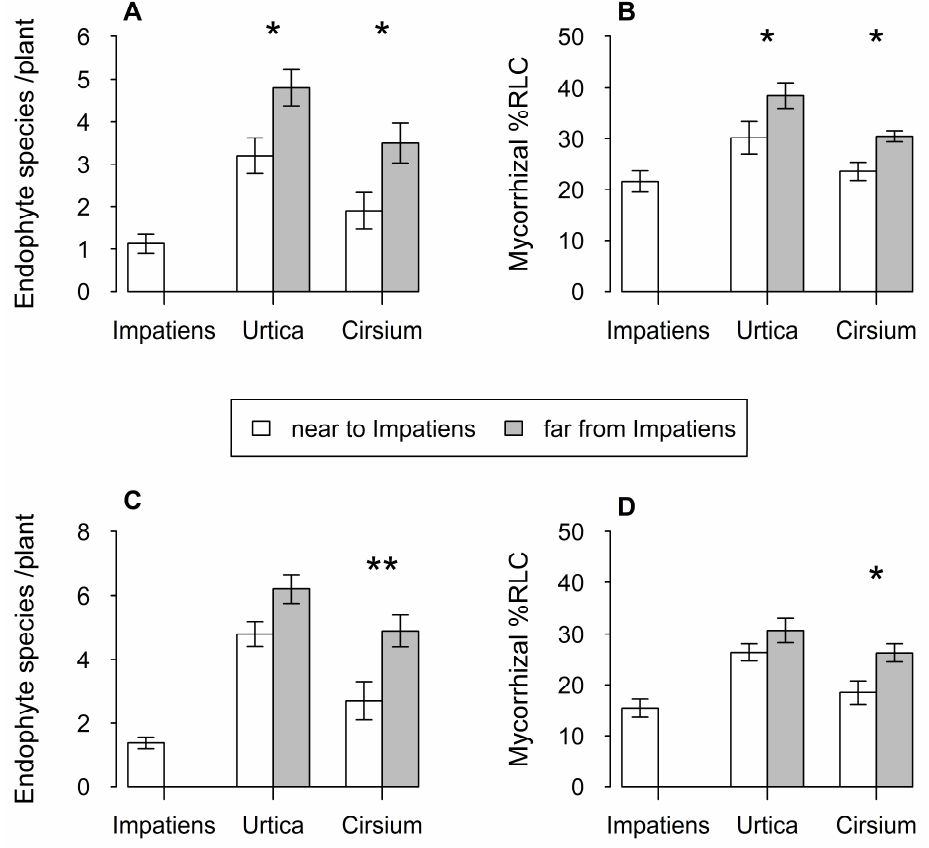
Figure 4. Mean number of endophyte fungal species per plant and percent root length colonised (RLC) by AM fungi of Urtica dioica and Cirsium arvense in two localities; Royal Holloway ( A , B ) and Zeals ( C , D ). White bars indicate plants growing interspersed with I. glandulifera stands, grey bars indicate plants over 100 m from these stands. The mean values for I. glandulifera are also given for each locality. Vertical lines represent ± one standard error. Asterisks above bars indicate significance of difference between means, *: p < 0.05; **: p < 0.01.